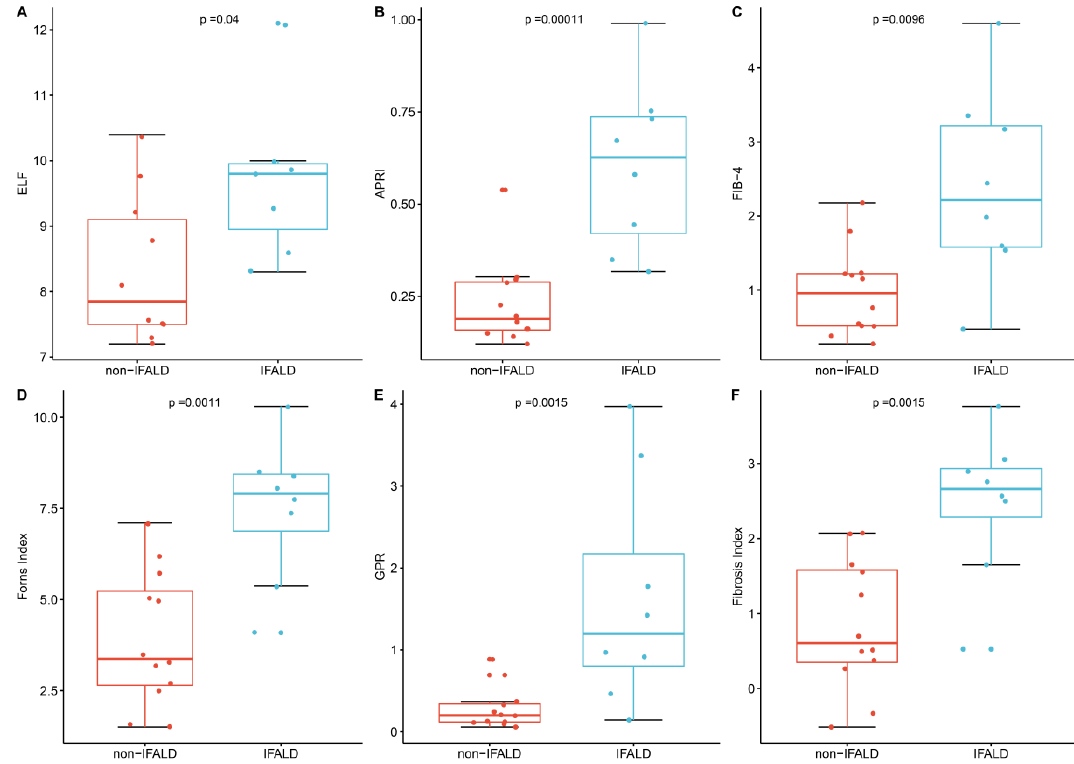
Figure 1. Comparison of liver scores between Intestinal Failure-Associated Liver Disease (IFALD) patients and non-IFALD patients, with respect to (A) Enhanced Liver Fibrosis (ELF); (B) Aspartate transaminase-to-Platelet Ratio Index (APRI); (C) Fibrosis 4 (FIB-4); (D) Forns Index; (E) Gamma-glutamyl transferase-to-Platelet Ratio (GPR); and (F) Fibrosis Index. Table 4. Comparisons of non-invasive hepatic fibrosis scores between adult participants with IF diagnosed with IFALD or no IFALD by radiological examinations (mean ± SD and median